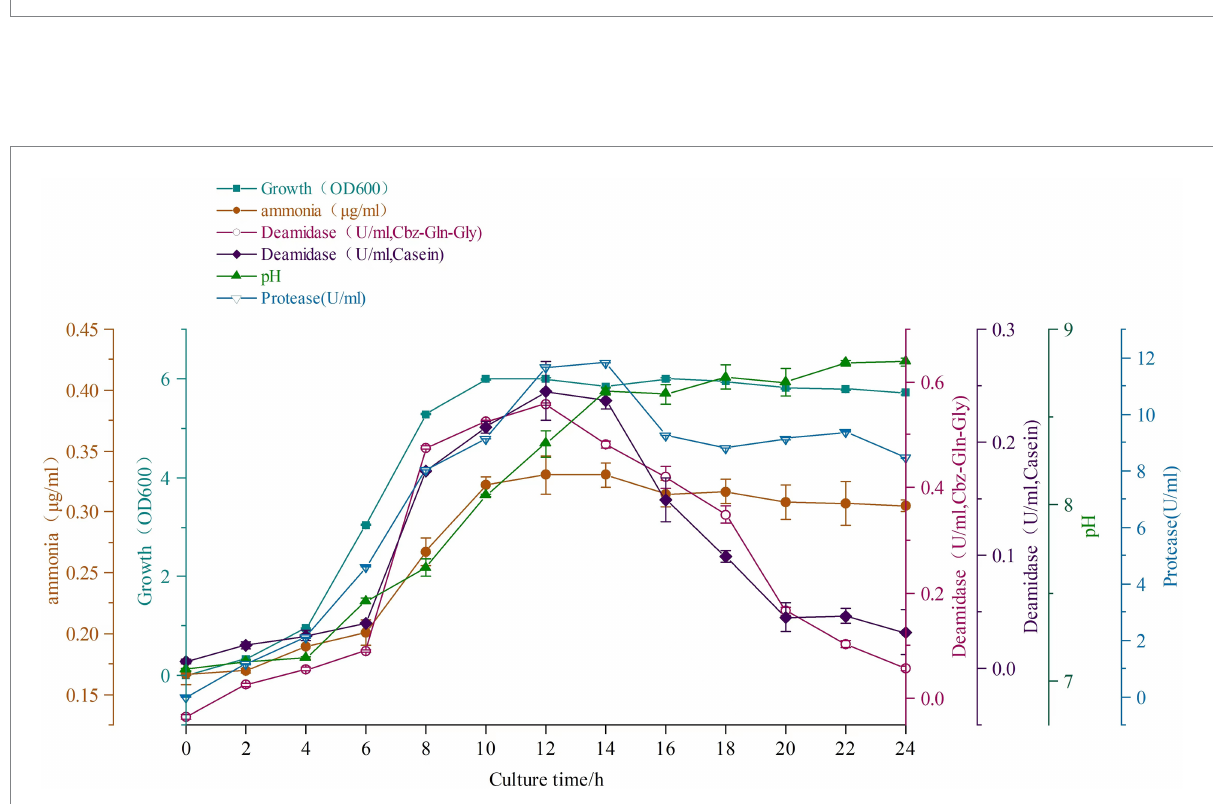
FIGURE 3 The batch culture profile of strain Chryseobacterium cucumeris ZYF120413-7.